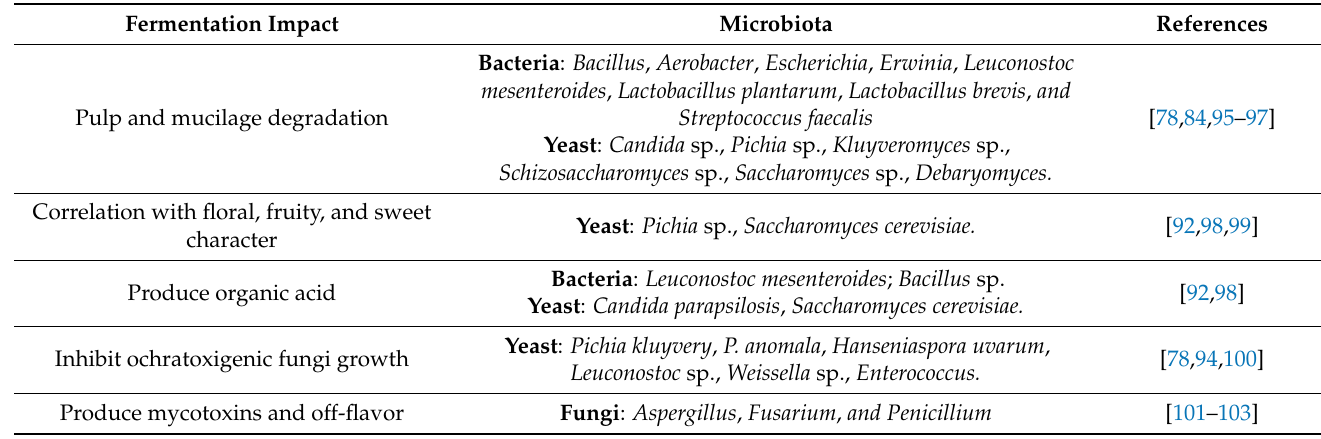
Table 3. The role of microorganisms during coffee